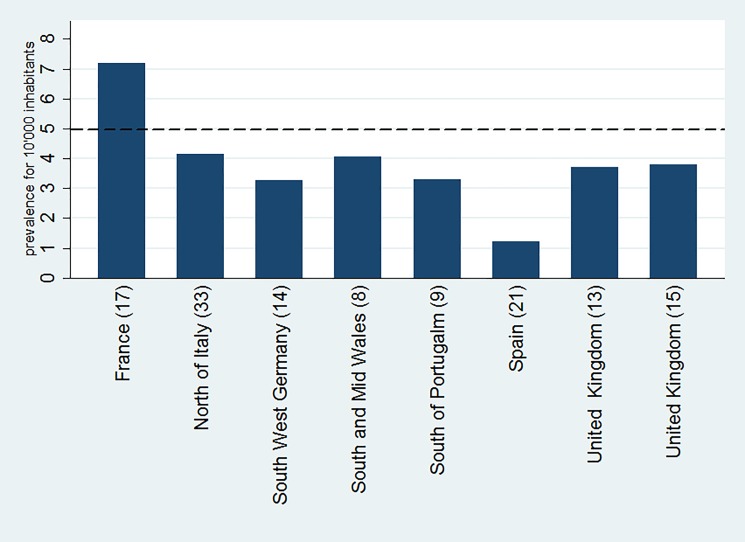
The figure depicts the predicted prevalence reported in the selected epidemiological studies[9, 10, 14–16, 18, 22, 35].Point prevalence was reported if predicted prevalence was not available. the dotted line indicates the limit of 5 cases: 10,000 inhabitants adopted by EMA to define rare disease.